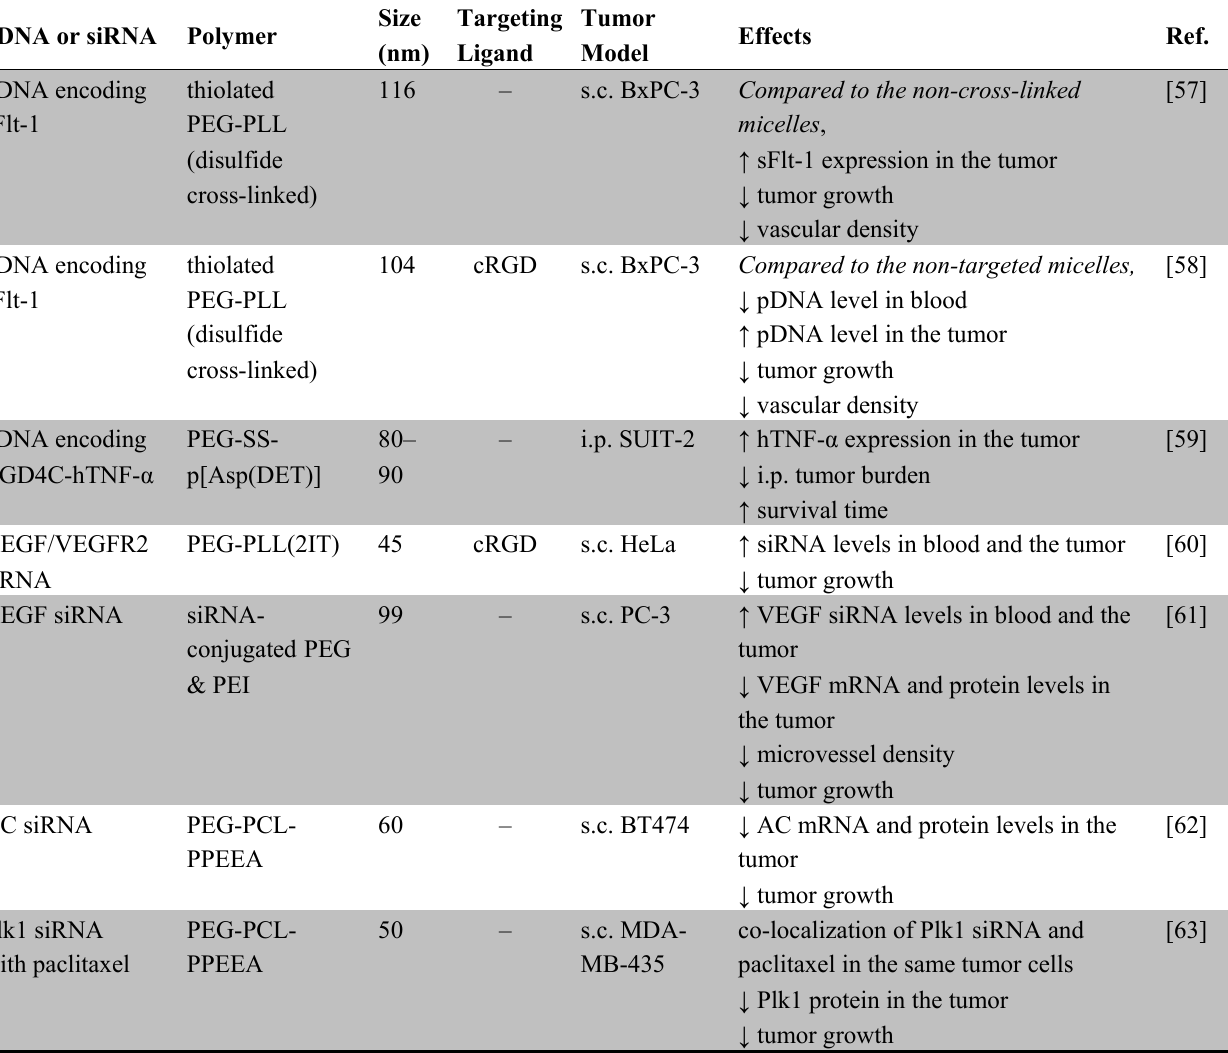
Table 4. Tumor-specific delivery of pDNA and siRNA is achievable via polyplex micelles. pDNA or